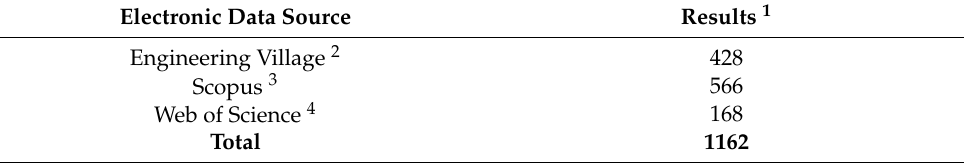
Table 1. Result by Data